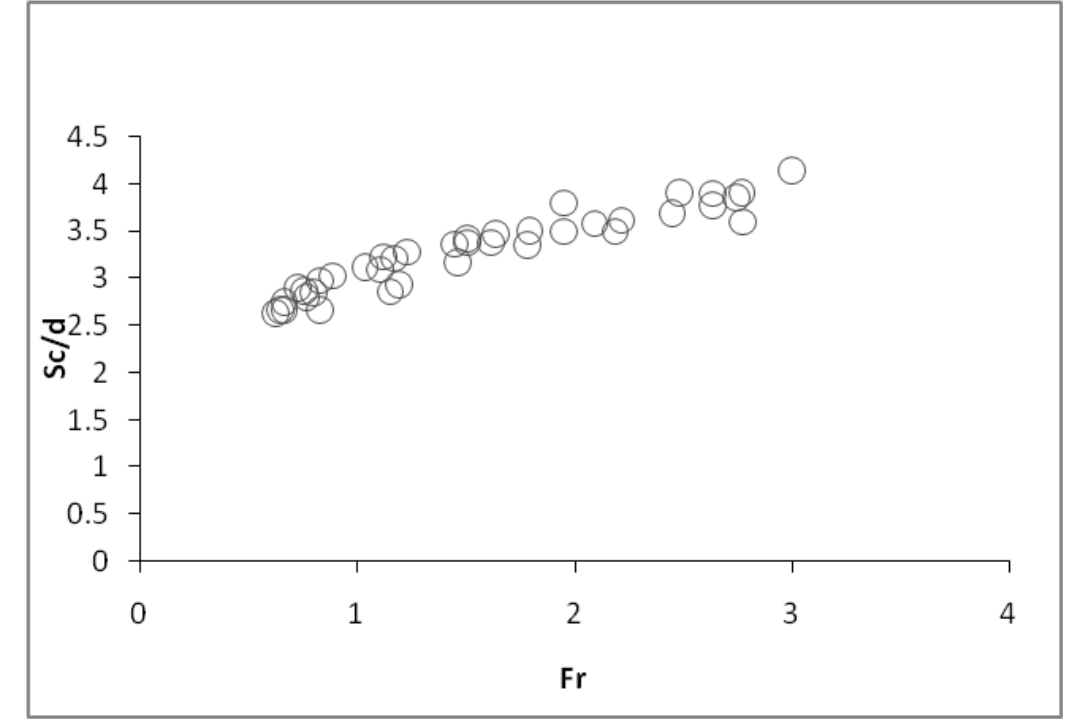
Fig. 2 The experimental results of the critical submergence at various Froude numbers (Intake No.1)